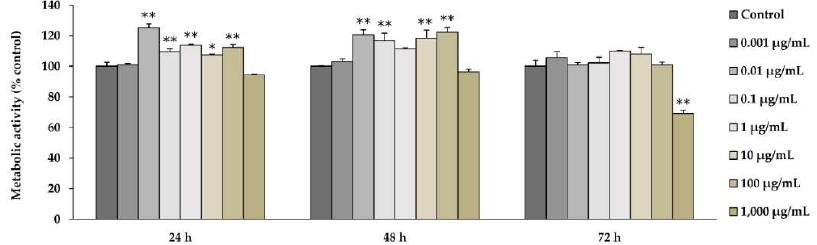
Figure 2. The effect of L -quebrachitol on the cell viability of MC3T3-E1 cells. MC3T3-E1 cells were treated with L -quebrachitol at various concentrations for 24, 48, and 72 h. Cell viability was measured by MTT assay. A representative example of 3 independent experiments. Each data point represents the means of 4 replicate samples ± SEM. * p < 0.05 and ** p < 0.01 when compared with the control.